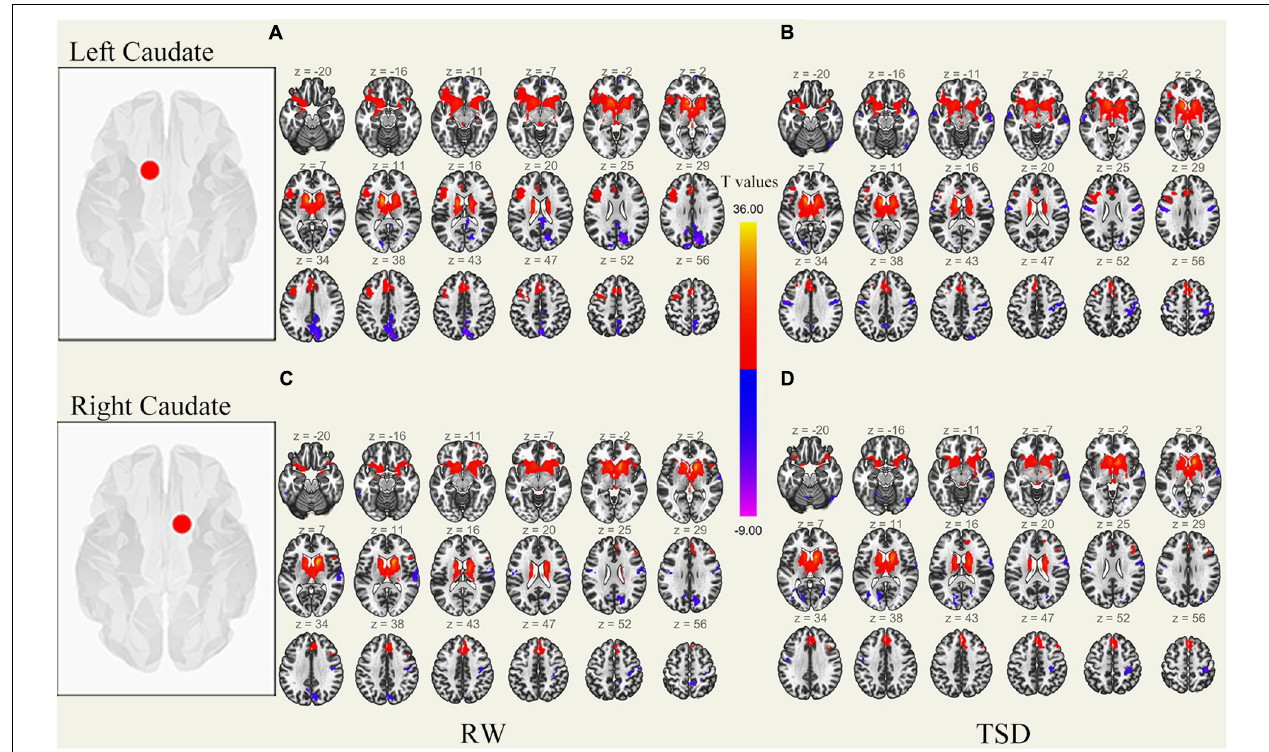
FIGURE 3 | Whole-brain functional connectivity patterns of the caudate before 36 h TSD shown at panels (A,C) , and after 36 h TSD shown at panels (B,D) ( n = 30) (Transverse view). Warm colors indicate positive correlations, and cold colors indicate negative correlations.